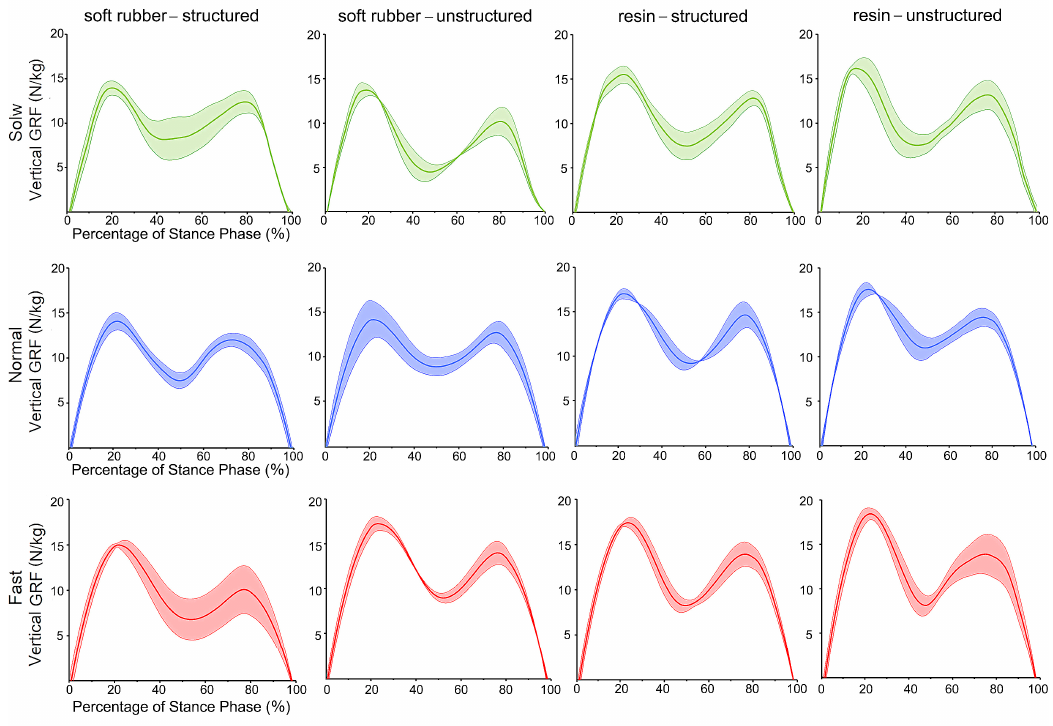
Figure 9. Time trajectories of the vertical GRF of the four bionic heel pads in one walking gait cycle at different speeds. Mean ± standard deviations were depicted, n = 5.